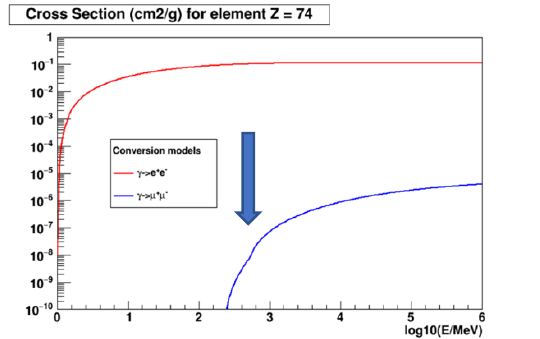
Fig. 3. Geant4 10.6 cross sections of lepton pair production in a tungsten target as a function of gamma energy. The arrow shows approximate working point for the Gamma Factory